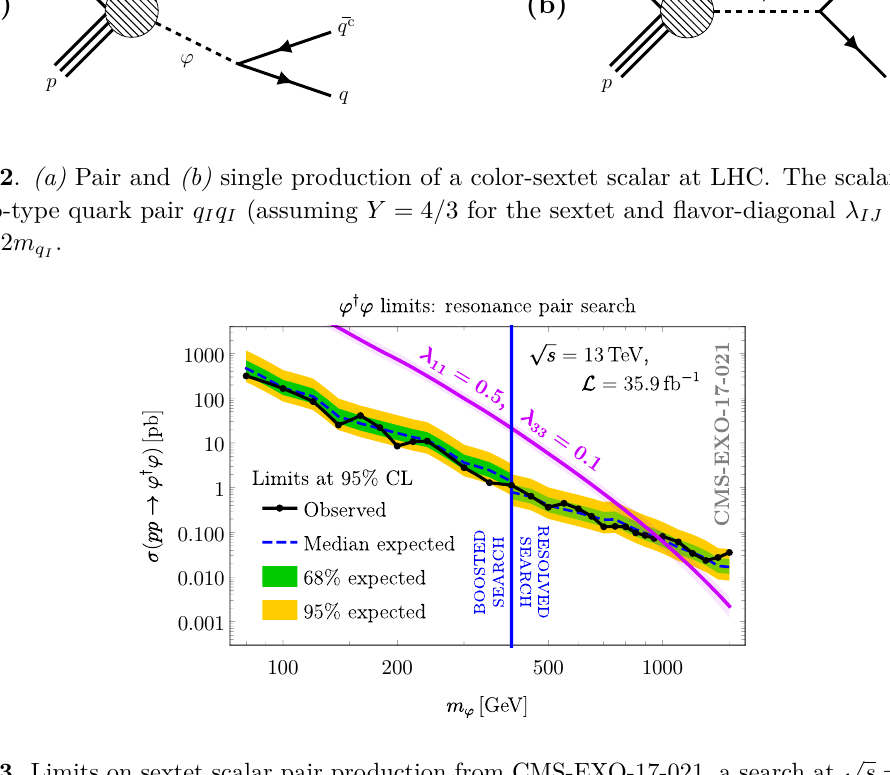
Figure 3 . Limits on sextet scalar pair production from CMS-EXO-17-021, a search at for pair-produced resonances decaying to light quarks. Displayed in purple is σ ( pp → ϕ † ϕ → uu ¯ u ¯ u ) for λ 11 = 0.5 , λ 33 = 0.1